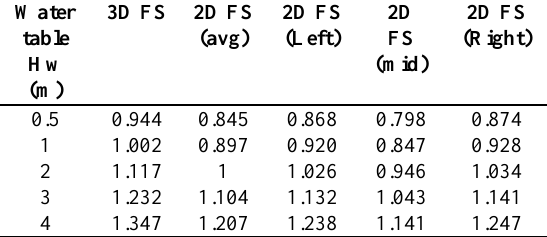
Table1. Calculated safety factor